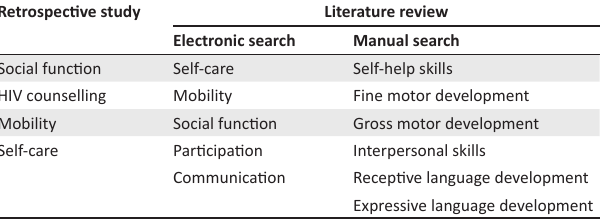
TABLE 4a: Identified functional domains. Retrospective study